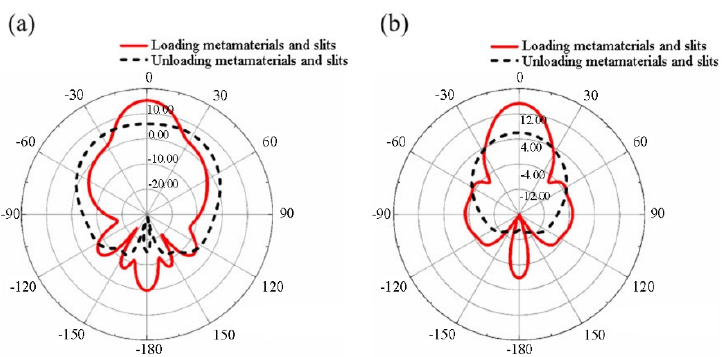
Figure 11. Radiation pattern of a microstrip antenna and a reference antenna loaded with metamate- rials ( a ) E -plane ( b ) H -plane. rials ( a ) E -plane ( b ) H